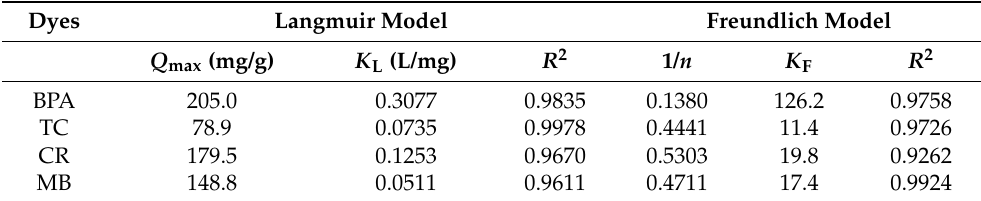
Table 3. Isotherm Parameters of Fe 3 O 4 @MIL-53(Al) for BPA, TC, CR, and MB Adsorption.